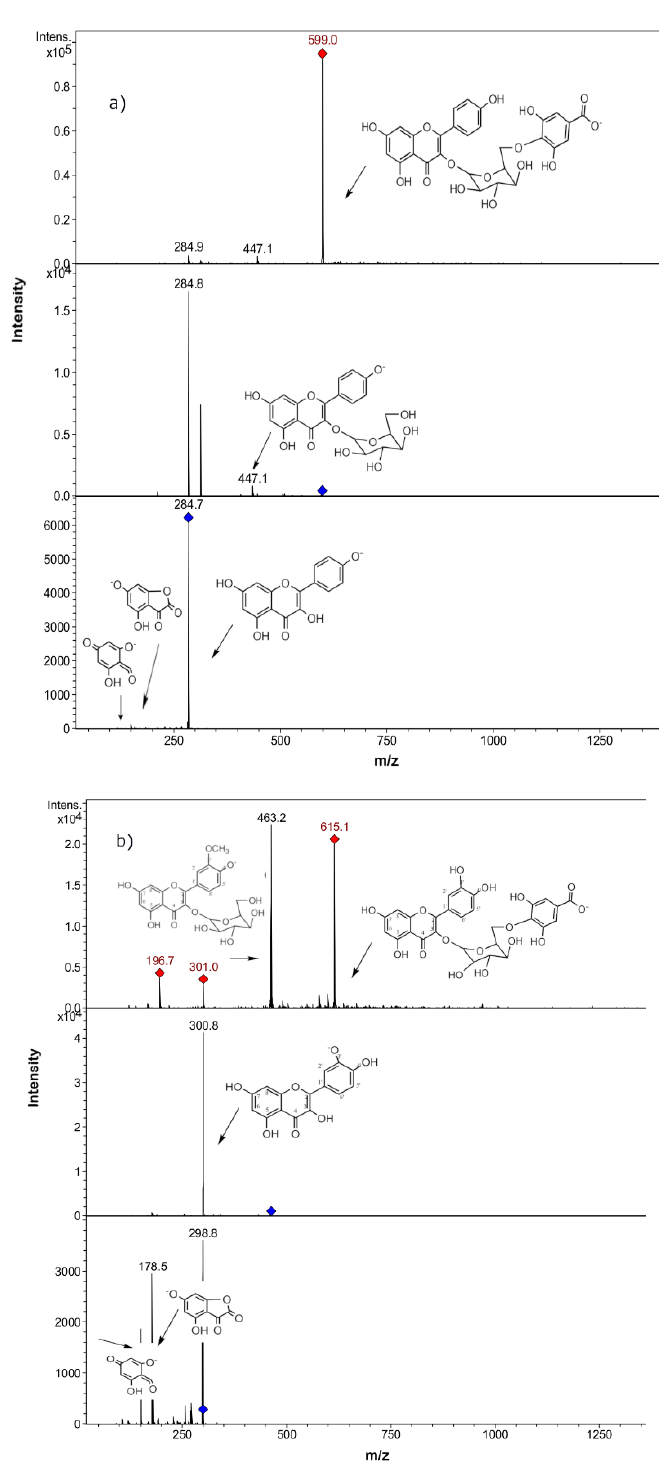
Figure 2. Full MS (upper panel) and MS1 (medium panel) and MS2 (lower panel) spectra of compound 20 , tentatively identified as Kaempferol ‐ O ‐ galloyl ‐ hexose, ( a ) and compound 21 , tentatively identified as Isorhamnetin ‐ O ‐ galloyl ‐ hexose ( b